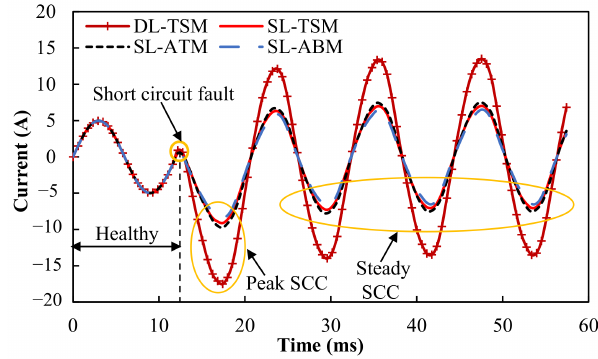
Figure 10. Single-phase SCC waveform of different machines at 1000 r/min.